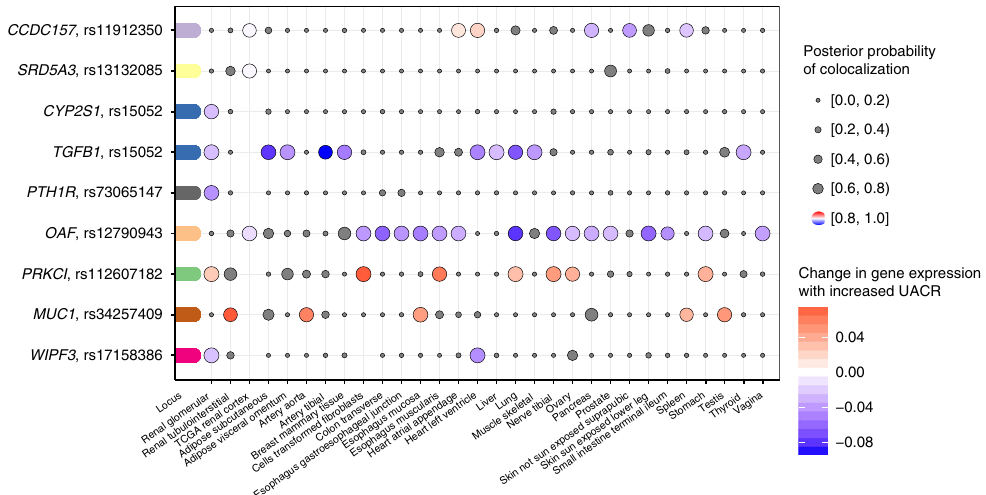
Fig. 6 Co-localization of associations signals for urinary albumin-to-creatinine ratio (UACR) and gene expression in kidney tissues. The plot shows the nine genes for which there is a high likelihood (posterior probability ≥ 80%) of a shared causal signal for gene expression in at least one of three kidney tissues and UACR. The loci are colored-coded and shown on the y -axis with the closest gene next to the index SNP. Co-localization with gene expression across all tissues ( x -axis) is shown as dots, where the size of the dots (implying that eQTL data were available) corresponds to the posterior probability of the co- localization. The change in UACR is color-coded relative to the change in gene expression, or gray in case of a posterior probability < 8 with inter-alpha-trypsin inhibitor heavy chain 1 (ITIH1) concentrations.